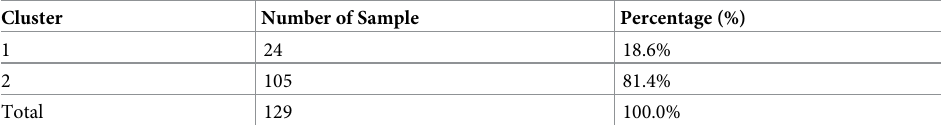
Table 4. Cluster distribution of rented car usage.